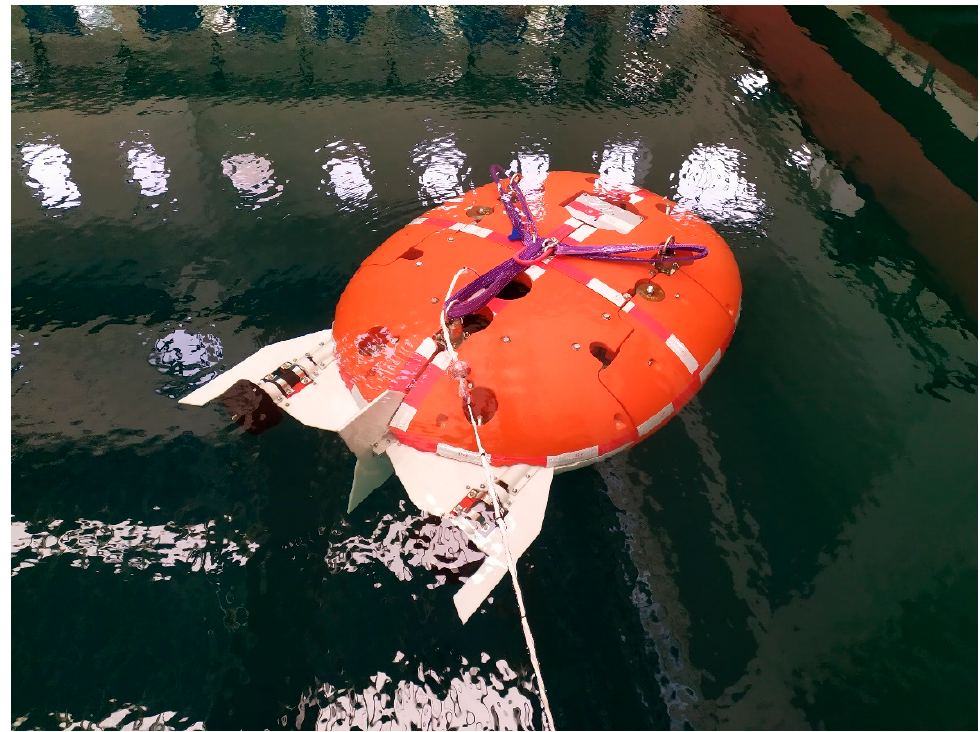
Figure 10. Model residuals of the fixed model-based fault detection method during sea trial of the HOV.